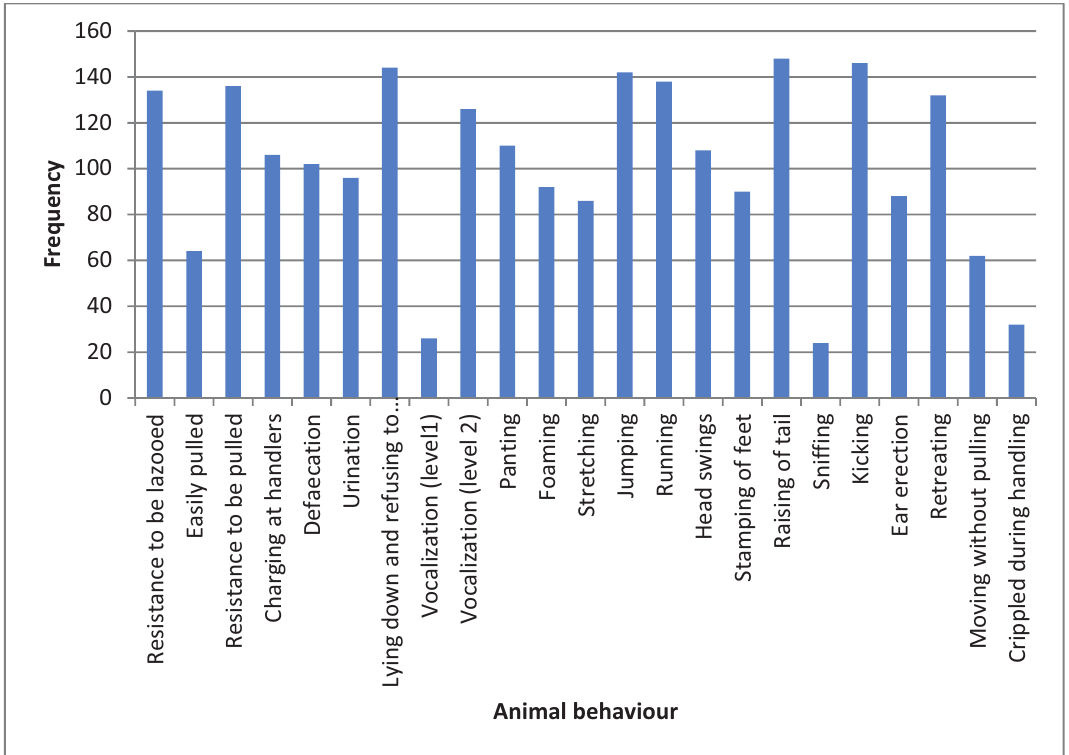
Figure 1. Frequency of occurrence of regularly-occurring behaviours exhibited by cattle (n = 200) as they were moved from the cattle market into the abattoir.